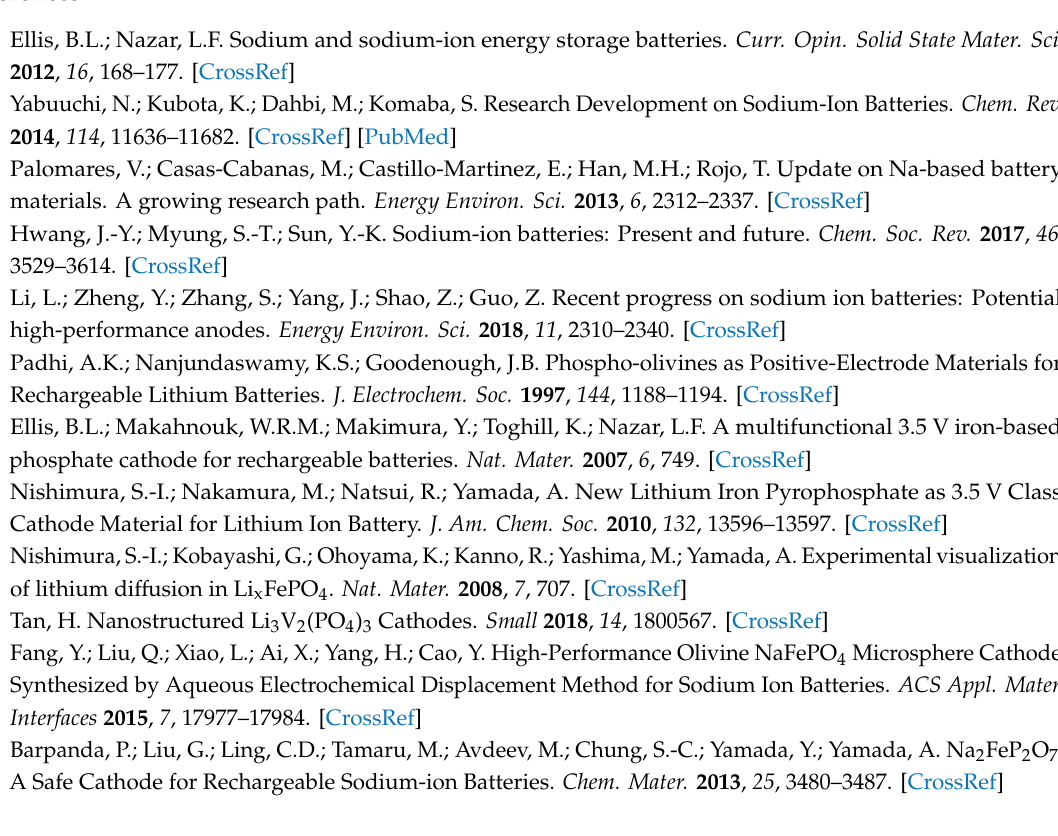
Table S1: Interatomic potential parameters used in the atomistic simulations of Na 3 Fe 2 (PO 4 ) 3